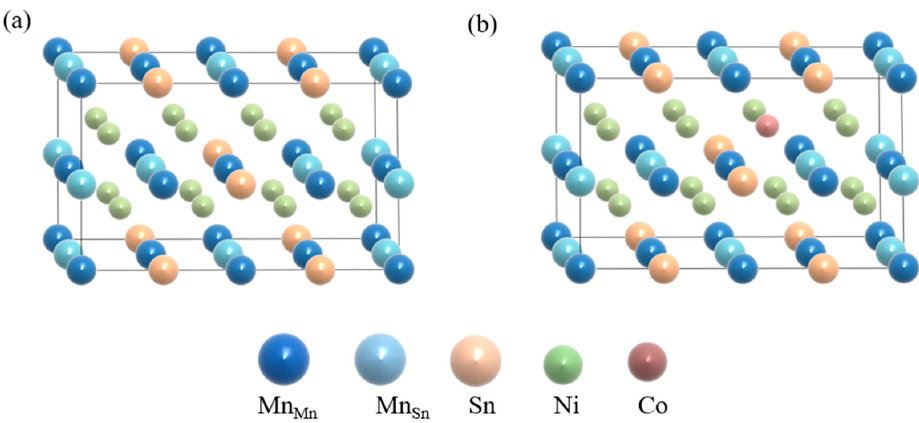
Figure 1. ( a ) Crystallographic structure in Ni 16 Mn 13 Sn 3 austenitic phase. ( b ) Crystallographic structure in Ni 15 CoMn 13 Sn 3 austenitic phase.